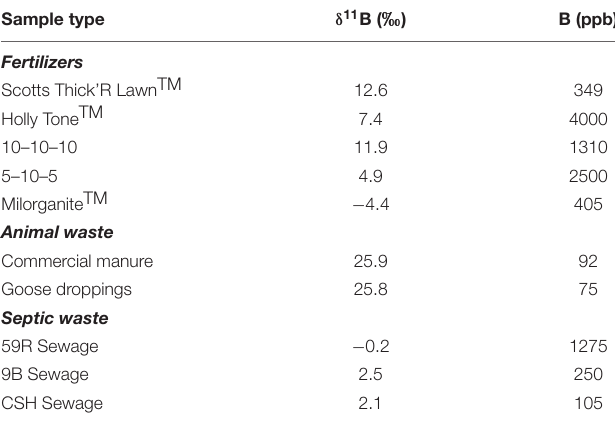
TABLE 2 | Summary of potential contaminant endmember δ 11 B isotopic values analyzed, including fertilizers, animals waste and septic waste. Sample